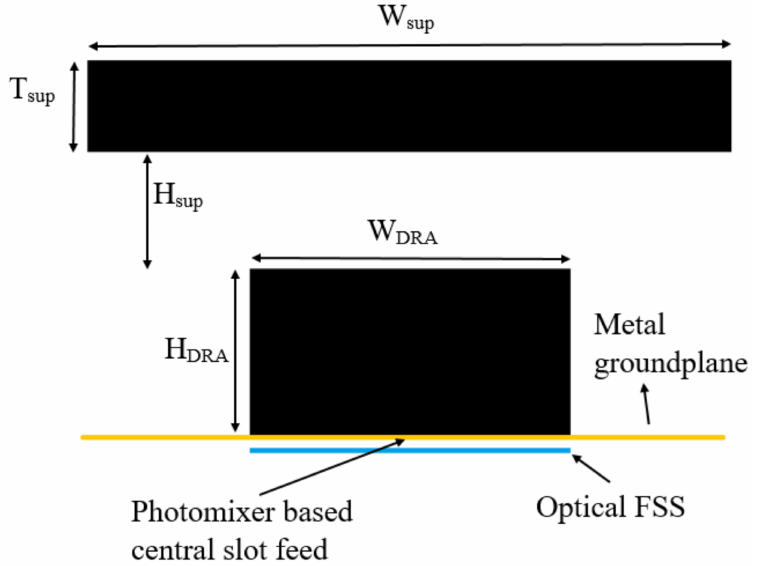
Figure 7. THz DRA and superstrate